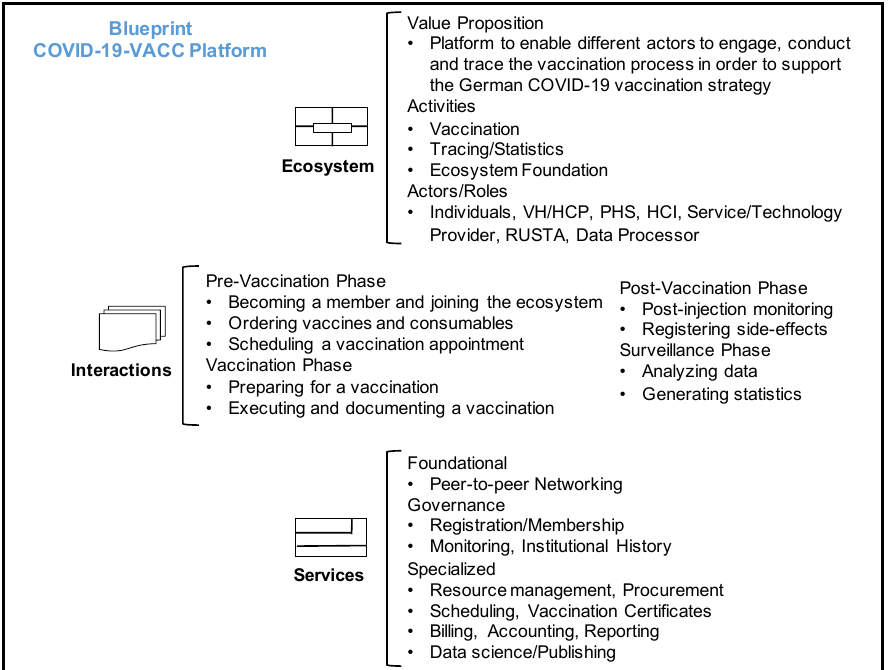
Figure 6. Blueprint of the COVID-19-Vacc Platform summarizing the primary outcomes of the modeling steps and activities (cf. Figure